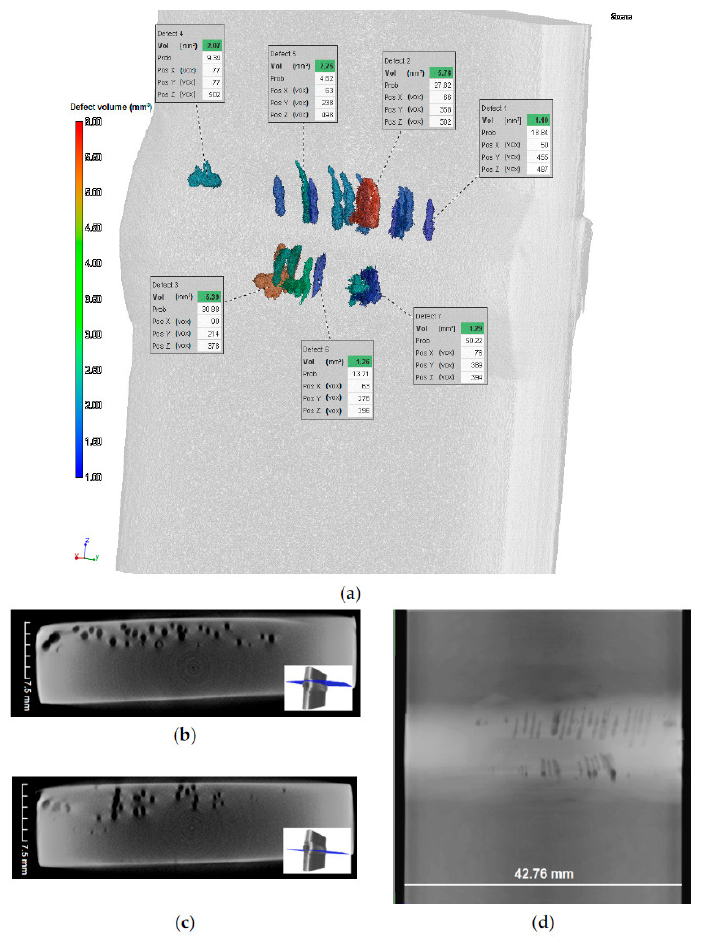
Figure 20. CT results for a specimen: ( a ) defect evaluation; ( b , c ) tomograms of the cross section of the weld bead and ( d ) some along X-rays of the joint. [128].